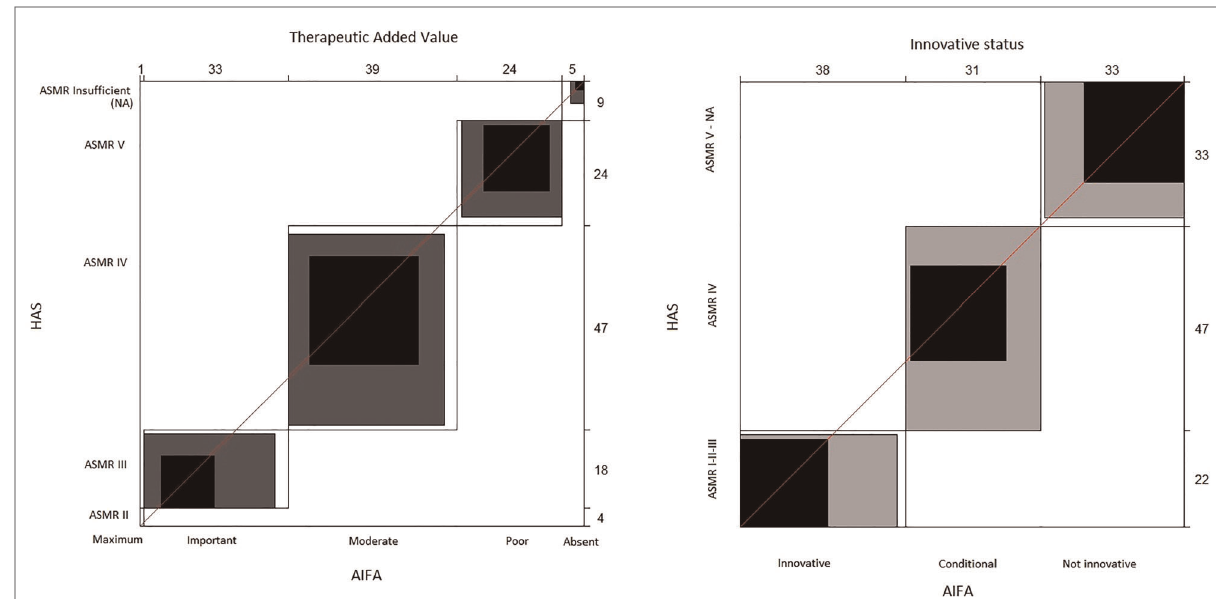
FIGURE 1 Agreement charts. The unweighted kappa treats all discrepancies equally; the weighted kappa assigns a different weight to discrepancies based on the magnitude of the discrepancy. When a perfect agreement is reached, rectangles are perfect-squared and the shaded squares are equal to the rectangles. Partial agreement is identi fi ed by comparing the area of blackened squares to the area of the rectangles. Observer bias can identify deviations from the 45° diagonal line. AIFA, Italian Medicines Agency; ASMR, Amélioration du Service Médical Rendu ; HAS, Haute Autorité de